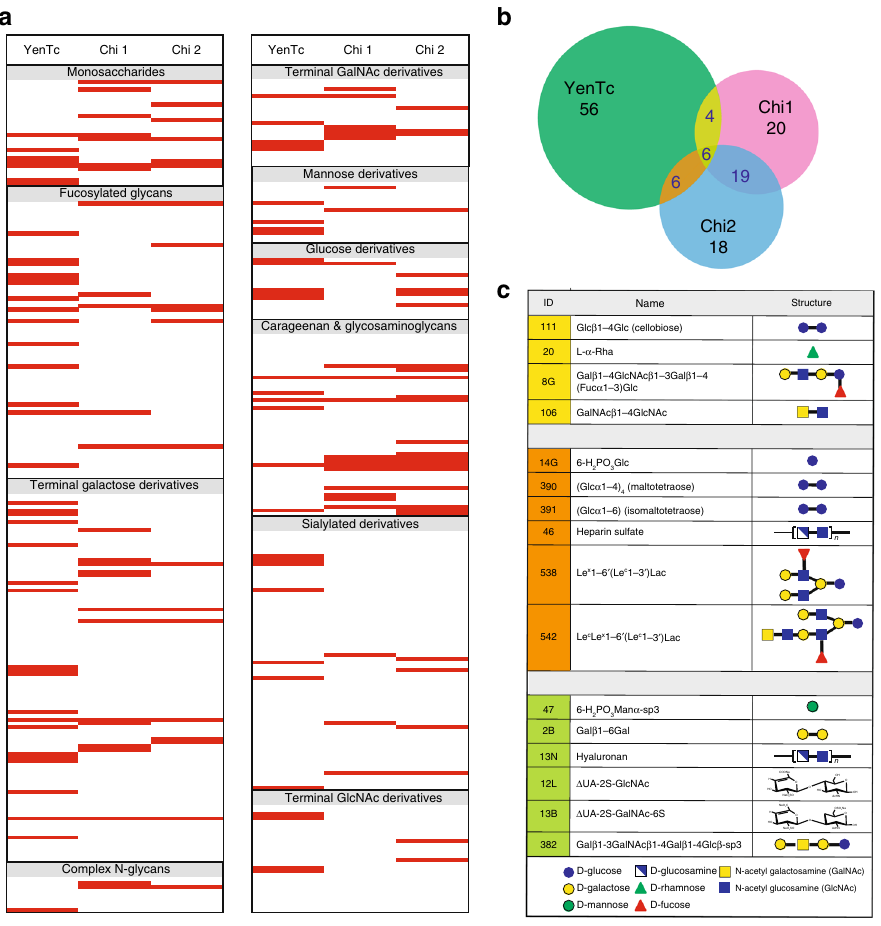
Fig. 5 Evidence for lectin-like properties of YenTc. a Binding pro fi le of the glycans grouped according to glycan property. Each red line indicates a hit to a glycan. The raw data used to produce the heat map shown in panel a are presented in Supplementary Fig. 11 and the full list of glycans printed on the arrays is given in Supplementary Data 1. b Venn diagram representation of overlapping hits between all three screens. In total, 72 glycan structures bound to YenTc including 56 that were unique to YenTc (in green). Chi1 and Chi2 both bound 49 glycan structures in total with 20 structures uniquely recognised by Chi1 (in pink) and 18 uniquely recognised by Chi2 (in blue). Four structures were recognised by both Chi1 and YenTc (yellow), the structures of which are represented in c and six structures were recognised by both Chi2 and YenTc (orange), also represented in c . Structures that were recognised by all three proteins are also shown in panels b and c